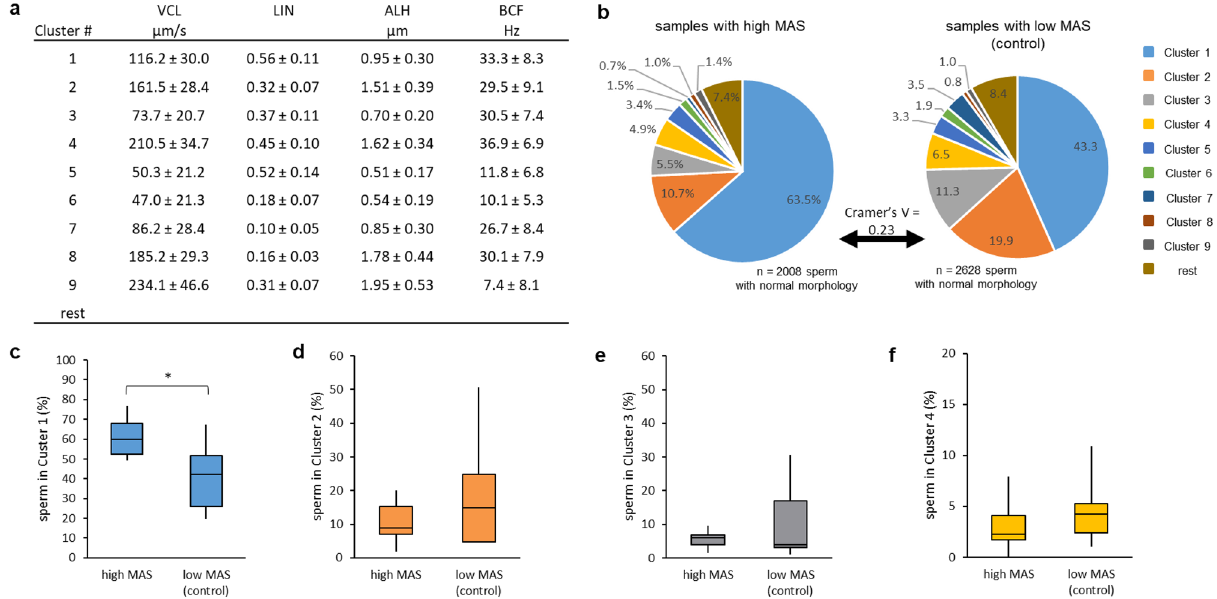
Figure 1. Distribution of morphologically normal spermatozoa originating from extended semen samples with either enhanced (≥ 15% = high MAS; n = 10 boars) or low (< 5% = low MAS; n = 9 boars) prevalence of cytoplasmic droplets and/or bent tails. Data are based on sperm tracks analysed after a 30-min incubation period at 38 °C in Beltsville Thawing Solution. ( a ) Motility descriptors (mean ± SD) are given for each cluster. b ) Distribution of spermatozoa to the individual cluster based on their origin from high MAS samples or low MAS samples. Cramer’s V indicates a small effect of the sample on sperm distribution. ( c )–( e ) Comparison of sperm distribution in high MAS samples (n = 10 boars) and low MAS samples (n = 9 boars) for Cluster 1 ( c ), Cluster 2 ( d ), Cluster 3 ( e ) and Cluster 4 ( f ). Boxes show the interquartile range. Vertical lines indicate minimum and maximum, while the horizontal line in the box indicates the median. An asterisk (*) indicates a significant difference between samples ( P <